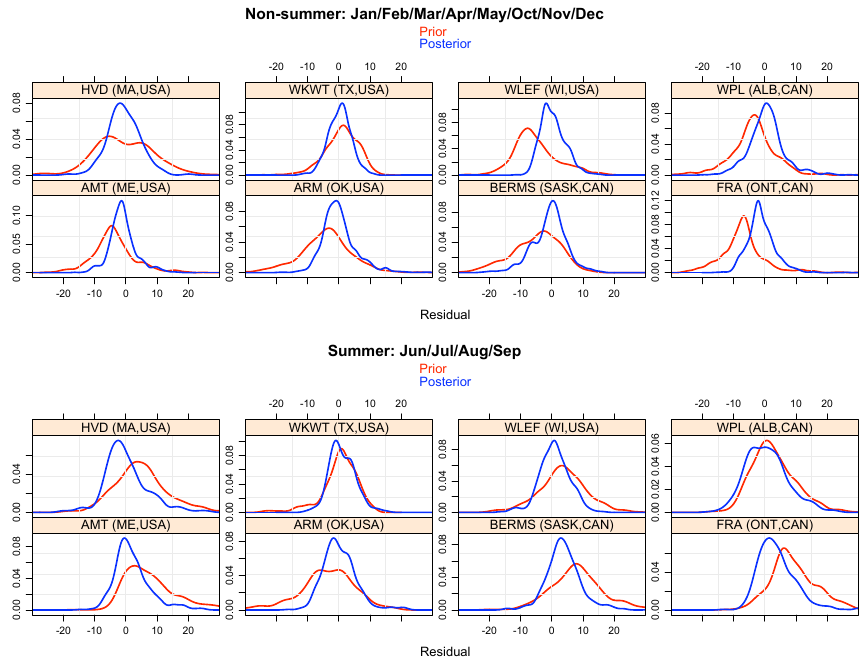
Fig. 5. Estimated probability density functions for modeled CO 2 residuals (observations – model), broken out by season and tower.